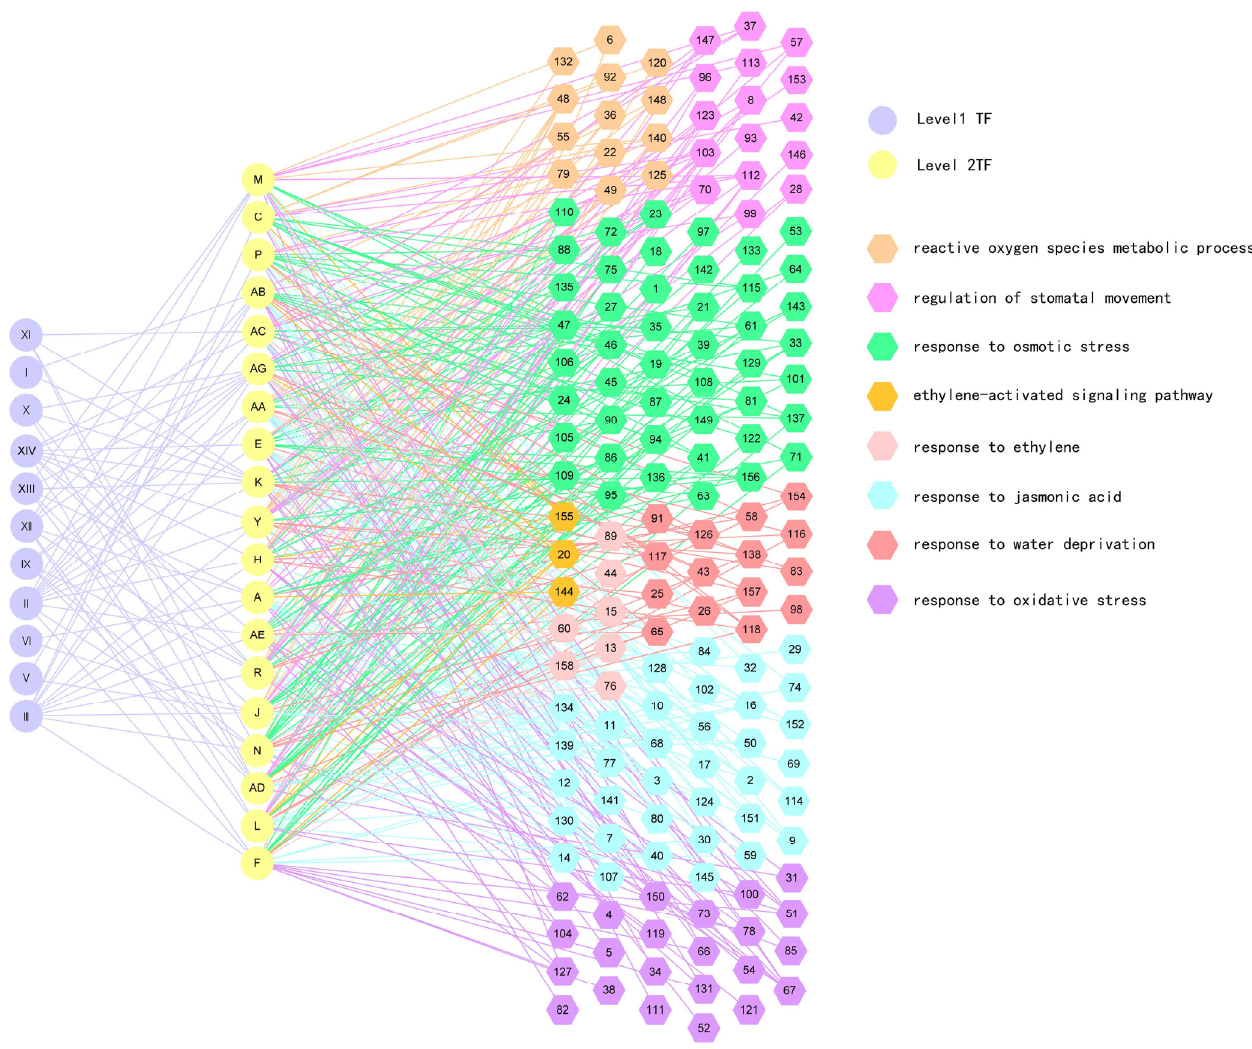
Figure 1. The gene regulatory network (GRN) of Populus davidiana × P. bolleana in response to PEG- induced drought stress. A three-layer GRN was constructed. The first layer contains 11 transcription